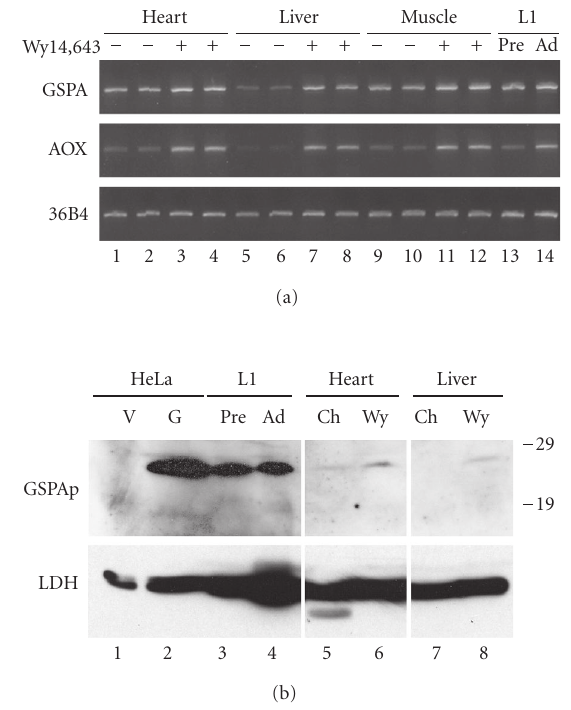
Figure 5: GSPA mRNA is expressed in a wide range of PPAR- expressing tissues and cells, while GSPA protein is exceedingly abundant in 3T3-L1 preadipocytes and adipocytes. (a) RT-PCR of RNA samples from the mouse heart, liver, and skeletal muscle, as well as 3T3-L1 preadipocytes (Pre) and adipocytes (Ad). Wild-type mice were fed with or without Wy14,643, two animals being used for each condition. RT-PCR was performed as in Figure 2. (b) West- ern blotting of protein samples from the mouse heart and liver, as well as 3T3-L1 preadipocytes (Pre) and adipocytes (Ad). Extracts prepared from HeLa cells transfected with a GSPA-expression vec- tor (G) and an empty vector (V) were analyzed in parallel to reveal the band position of GSPAp. Ch and Wy, tissue extracts from the mice fed normal chow or Wy14,643-containing diet, respectively. Anti-GSPAp antiserum was used at 200-fold dilution. Membrane was reprobed with anti-lactate dehydrogenase (LDH) antibody as a loading control. Other conditions were as described previously [13]. All samples were analyzed in a single gel. Positions of size markers (in kd) are shown on the